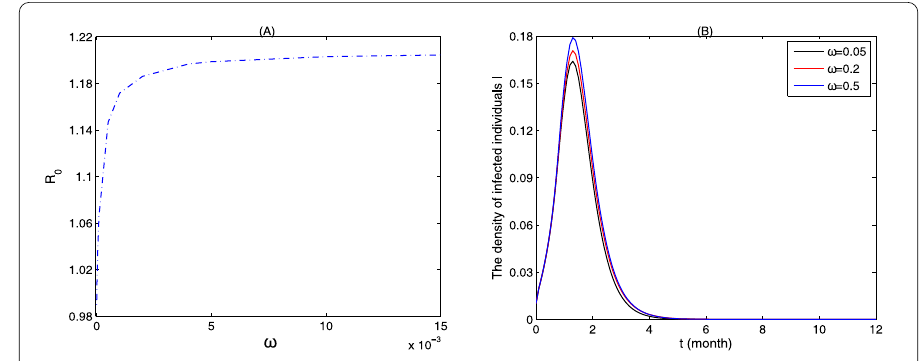
Figure 2 ( A ) The variation in R 0 with respect to the waning rate ω of immunity on the random network; ( B ) the density of infected individuals ( I =